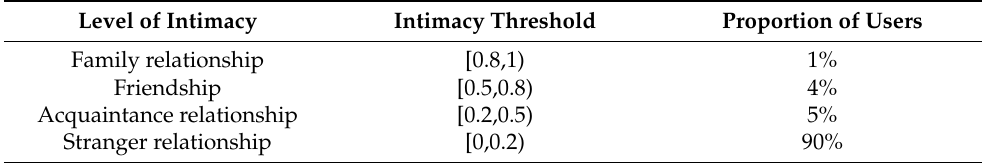
Table 3. Proportion of intimacy and distribution of value range.